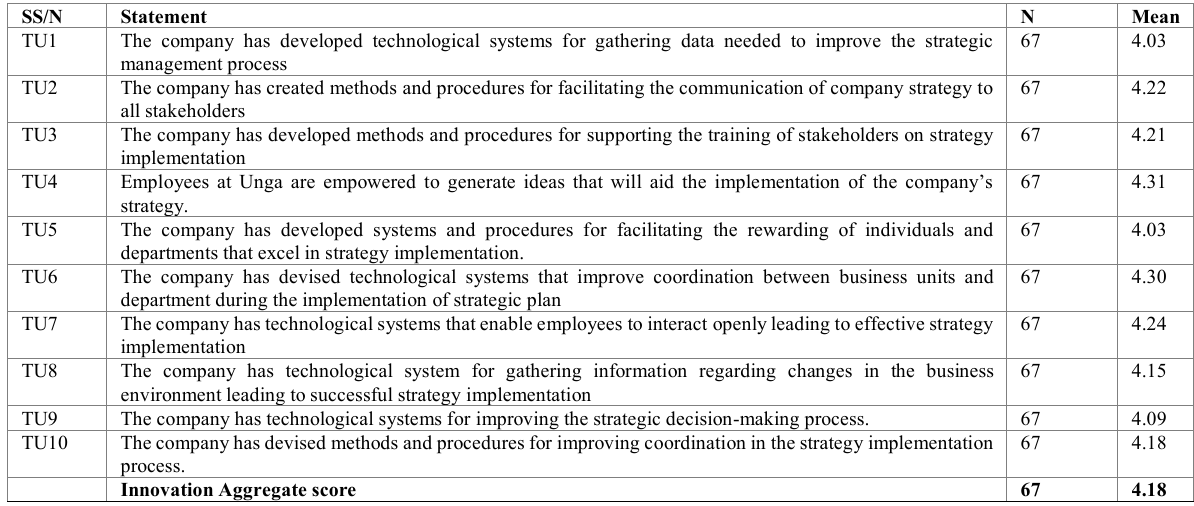
Table 3: Innovation in Strategy Implementation at Unga